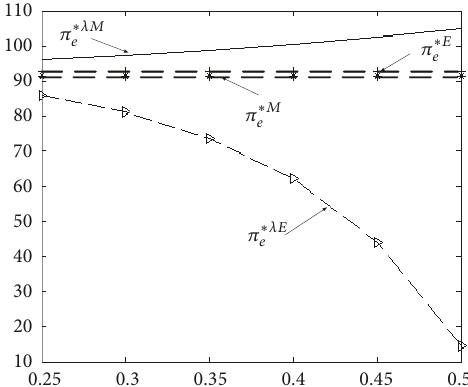
Figure 8: Change rule of sales price as 𝜆 changes.